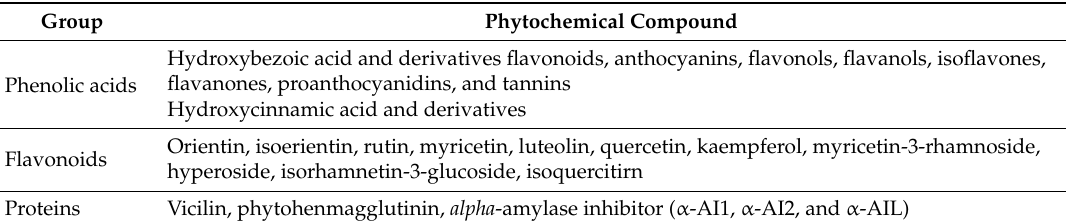
Table 4. Some major isolated phytoconstituents on P. vulgaris